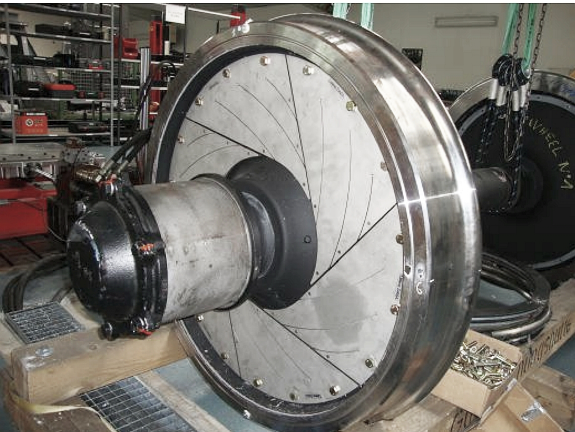
Figure 3. Railway wheel absorber (GHH-VALDUNES, Gutehoffnungshütte (GHH), Oberhausen, Germany, reprinted with permission from Ref. [9], Copyright 2012, GHH-Radsatz) consisting of two metal crescent plates with an constrained viscous damping layer as a bending waveguide to reduce wheel-radiated squeaking noises while cornering [10,11].